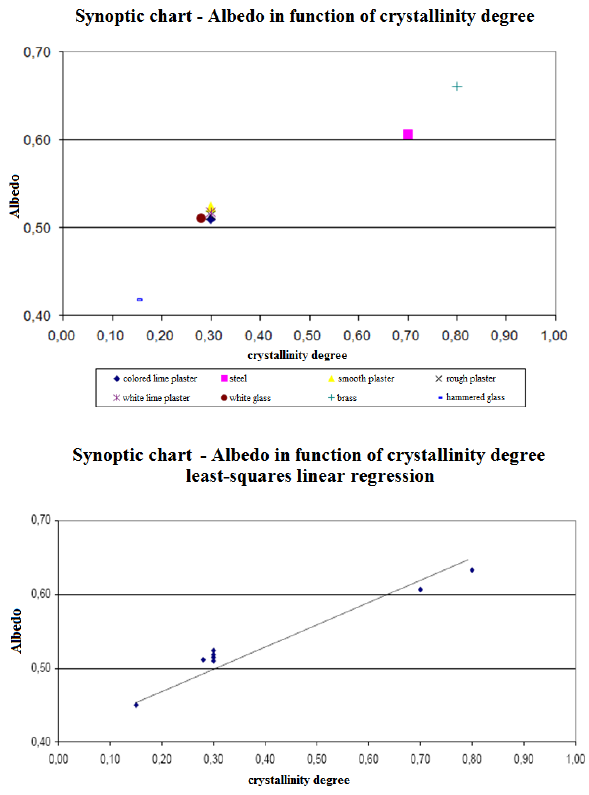
Figure 5 - Albedo whit azimuth range of 10 °, nadir shooting